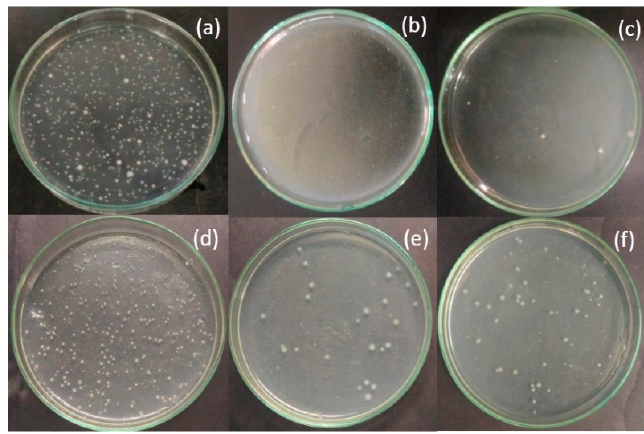
Figure 10. Antimicrobial activity of E. coli and S. aureus against TiO 2 and ZnO nanomaterials. ( a ) Control of S. aureus ; ( b ) FL–ZnO against S. aureus ; ( c ) FL–ZnO against E. coli ; ( d ). Control of E. coli ; ( e ) TiO 2 against S. aureus ; ( f ) TiO 2 against E. coli